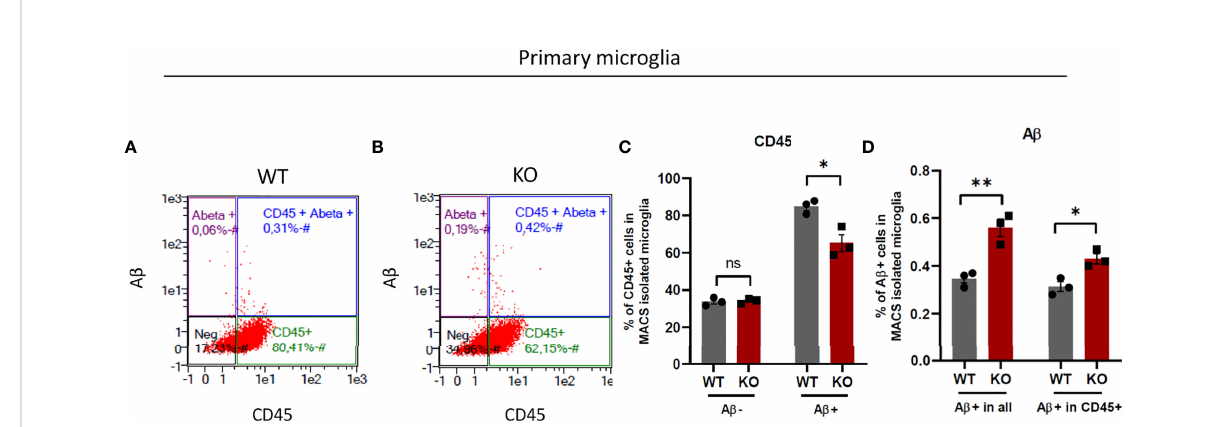
FIGURE 8 b 5i/LMP7 de fi cient microglia exhibit more phagocytosis activity. (A – D) Phagocytosis activity was determined by the analysis of TAMRA-A b + cell population in primary micrgolia. (A, B) Gating strategy of fl ow cytometry analysis of MACS isolated WT (A) and b 5i/LMP7 KO (B) microglia incubated with 2µM TAMRA-labeled amyloid-beta (A b ) toxic oligomers. (C) Bar graphs showing quanti fi cation of total CD45+ cells before A b treatment, total CD45+ cells after A b treatment, (D) Bar graphs showing quanti fi cation of total A b + cells and A b + cells in CD45+ cells in primary microglia. All data are given (n=3) by mean ± SEM; *: P < 0.05, **: P <